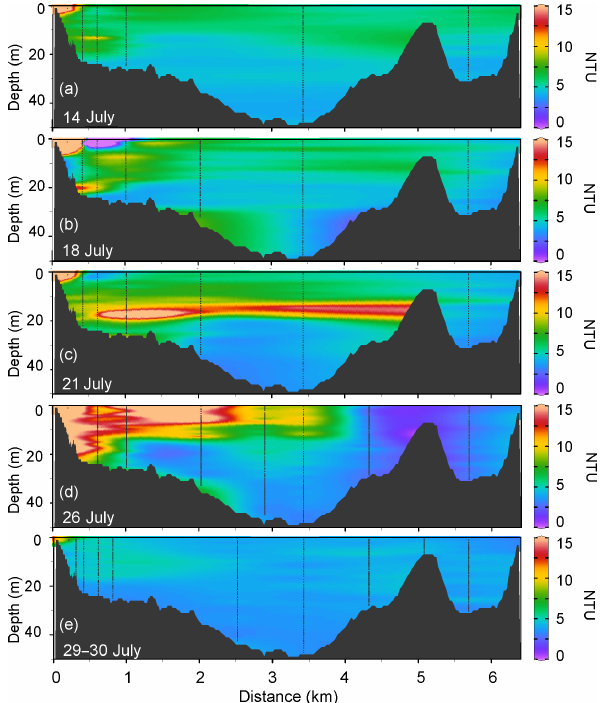
Figure 11. Turbidity in Lake Peters over the course of a precipi- tation event in July 2015; turbidity data are shown for (a) 14 July, (b) 18 July, (c) 21 July, (d) 26 July, and (e) 29 and 30 July (com- posite). Black shading indicates lake bathymetry, and black dashed lines indicate locations of TROLL casts. The x axis indicates north– south distance across the lake from the outflow of Carnivore Creek. Figure created using Ocean Data View (ODV)